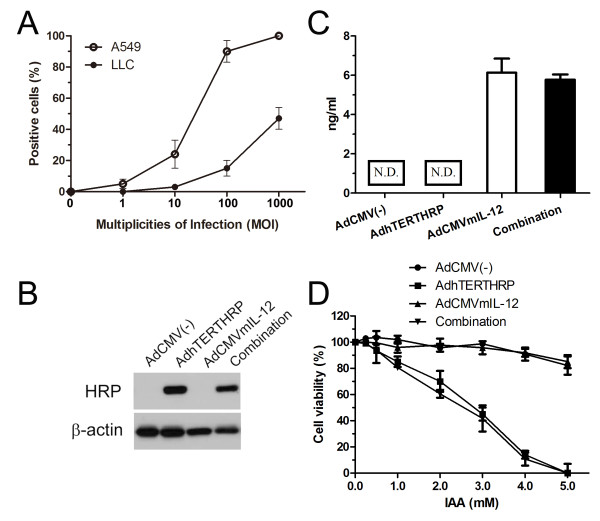
Transduction of adenoviruses in LLC cells in vitro. A, adenoviral gene transduction efficiencies in murine LLC and human A549 cell lines at indicated MOIs. B, HRP expression of LLC cells in various treatment groups was analyzed by western blot. C, IL-12 expression in the supernatant of LLC cells infected with AdCMV(-), AdhTERTHRP and/or AdCMVmIL-12 was quantified using mIL-12p70 ELISA kit following the manufacturer's instructions. N.D., no detection. D, effects of transduction with different adenoviruses followed by IAA treatment in LLC cells in vitro. Transduced cells were incubated with various concentrations of IAA for 5 days, and cell viability was determined by MTT assay. IC50 was calculated as the concentration of drug which inhibited cell growth by 50%. Data were representative of three independent experiments. Each point represented the means ± SEM and was expressed as percentage relative to drug-free cells.